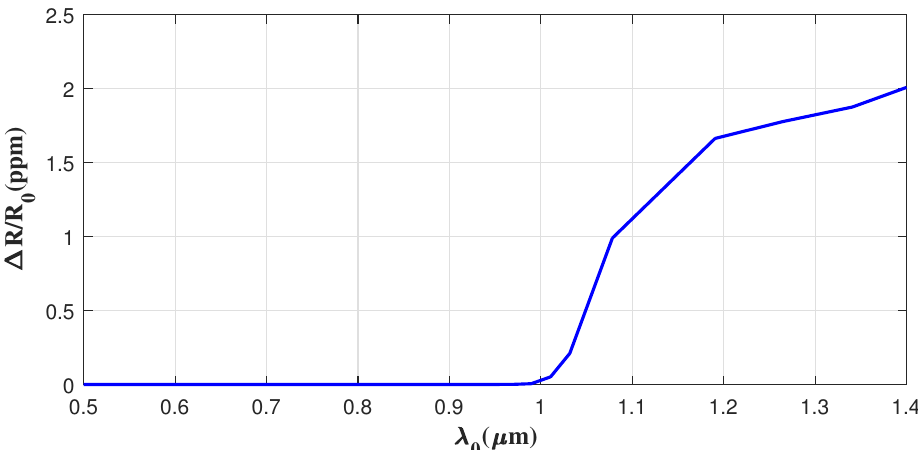
Figure 5. Relative reflectivity variation | ∆ R / R 0 | for V p = 4 V , considering the bandwidth of the laser ∆ λ = 2 nm.